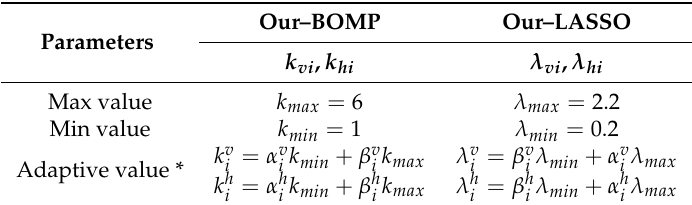
Table 1. Setting of sparsity controlling parameters. BOMP: batch orthogonal-matching-pursuit; LASSO: least-absolute-shrinkage-and-selection-operator.